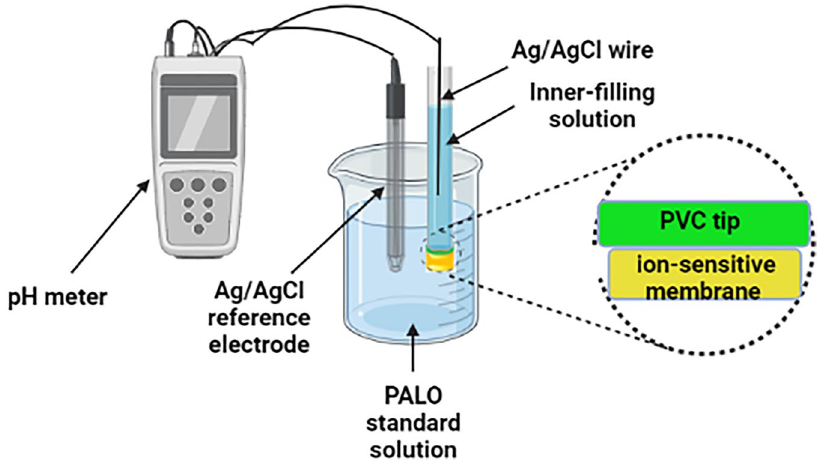
Figure 5. A diagram for measurement process using the proposed method. Figure 5 was created using BioRender (https:// biore nder.